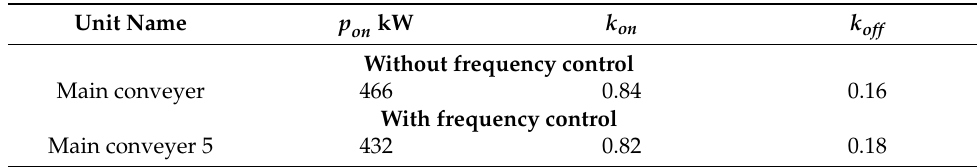
Table 12. Probabilistic design characteristics for the group ELC.